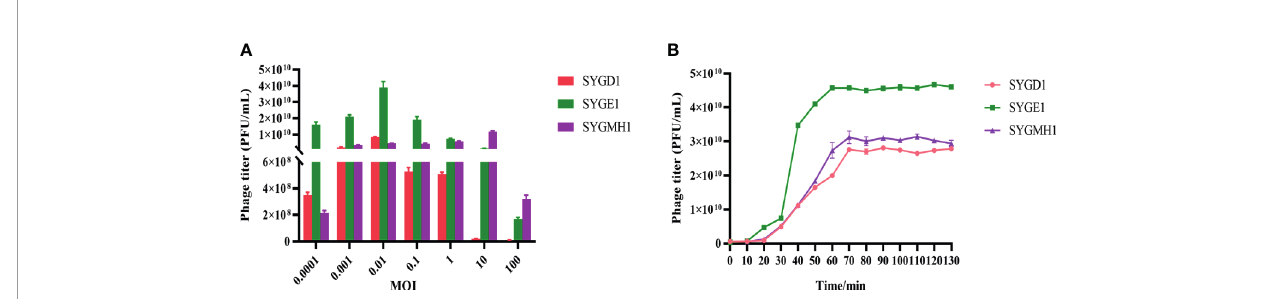
FIGURE 3 | The optimal MOI and one-step growth curve of phages. (A) vB_EcoM_SYGD1, vB_EcoP_SYGE1, and vB_EcoM_SYGMH1 infected their host strain at an MOI of 0.01 or 10, reaching their peak titer, indicating the most suitable concentration for lysing bacteria. (B) SYGD1, SYGE1, and SYGMH1 infected their host strains at the optimal MOI. The supernatants were harvested at 10 min intervals post-infection, and titers were determined using the